Question: Which visualization type does this figure use?
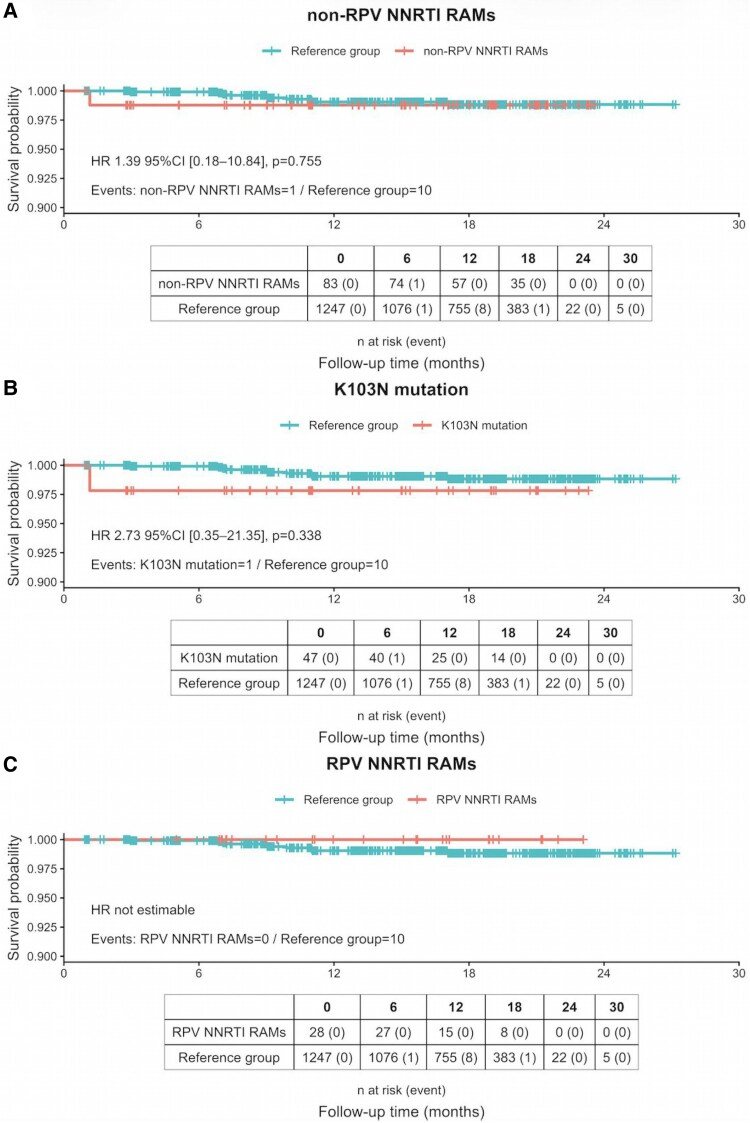
Answer: survival